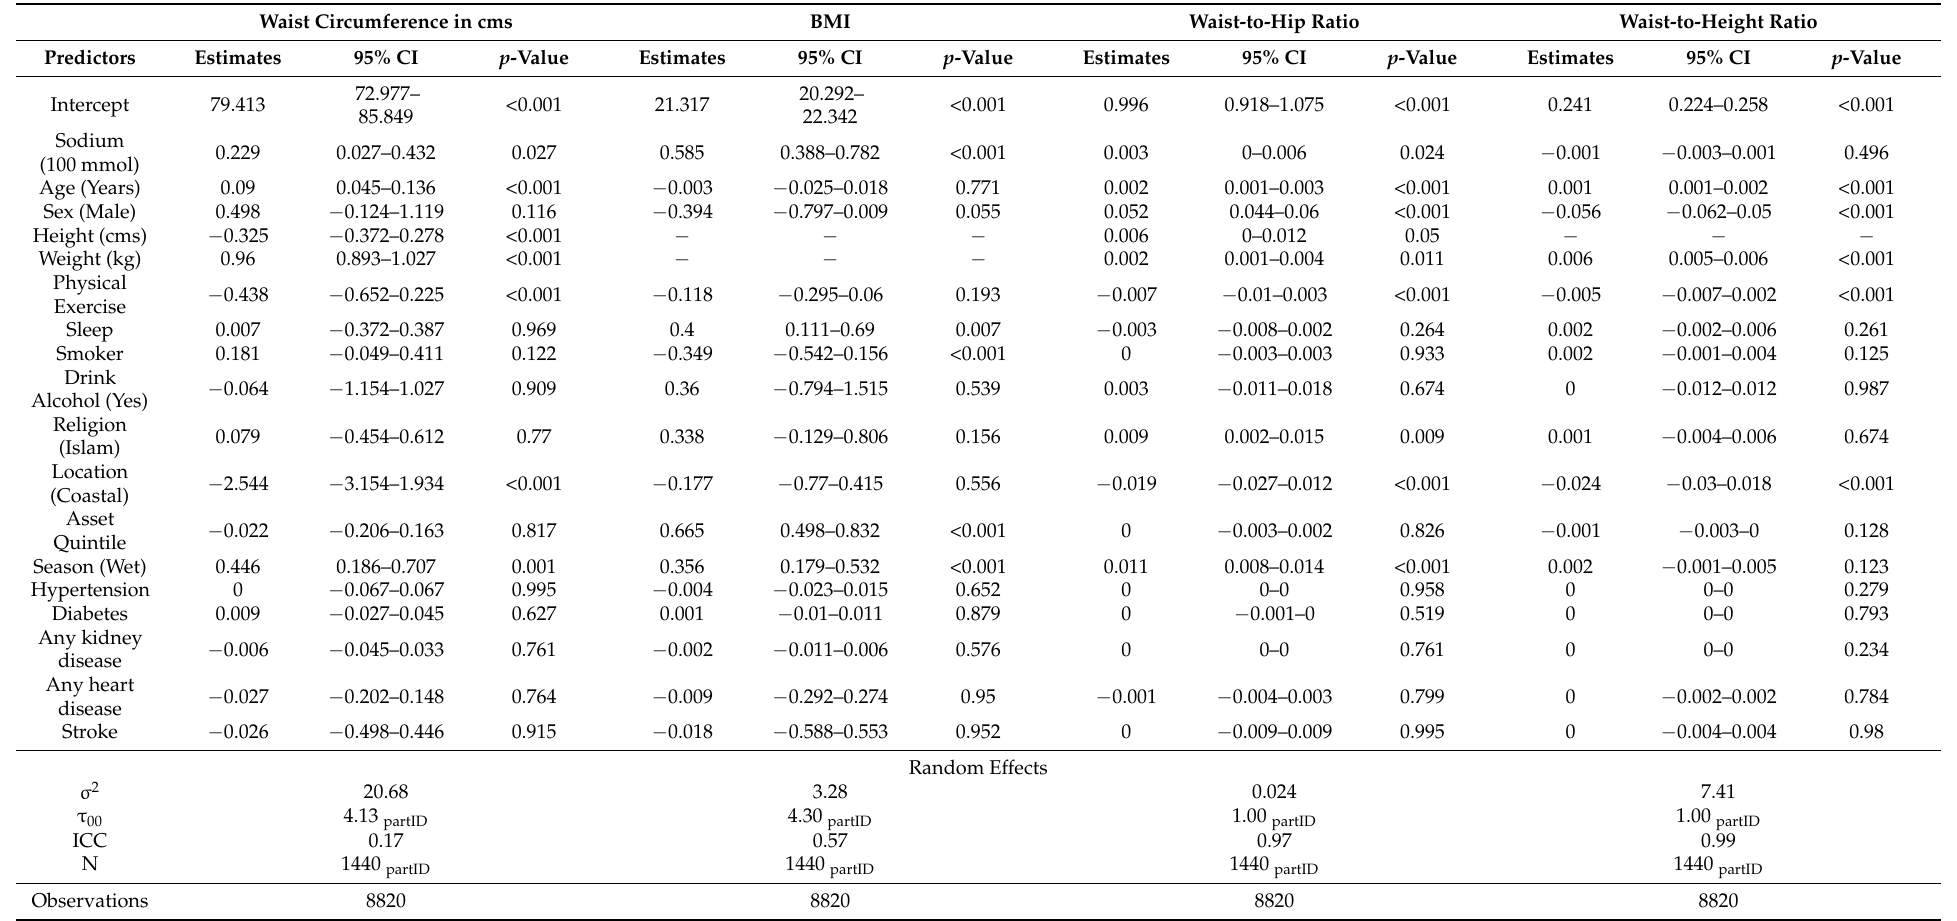
Table 8. Association between 24 h urinary sodium and 90% percentile waist circumference, BMI, waist-to-hip ratio and waist-to-height